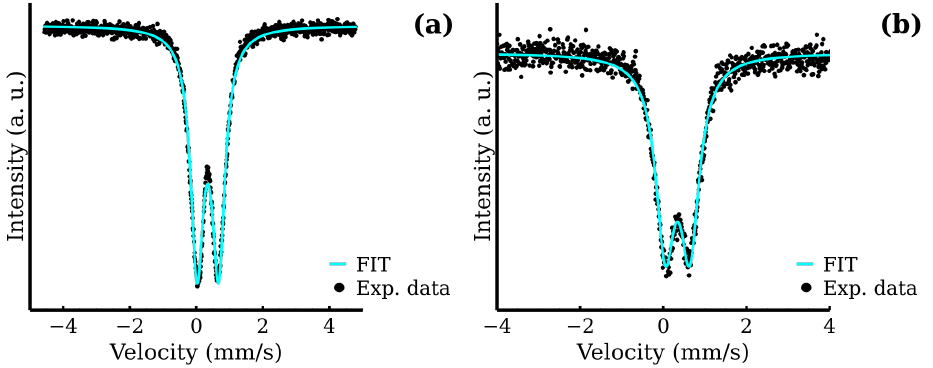
Figure 8. Room temperature Mössbauer spectra of MW samples: ( a ) MW-5 and ( b ) MW-30.